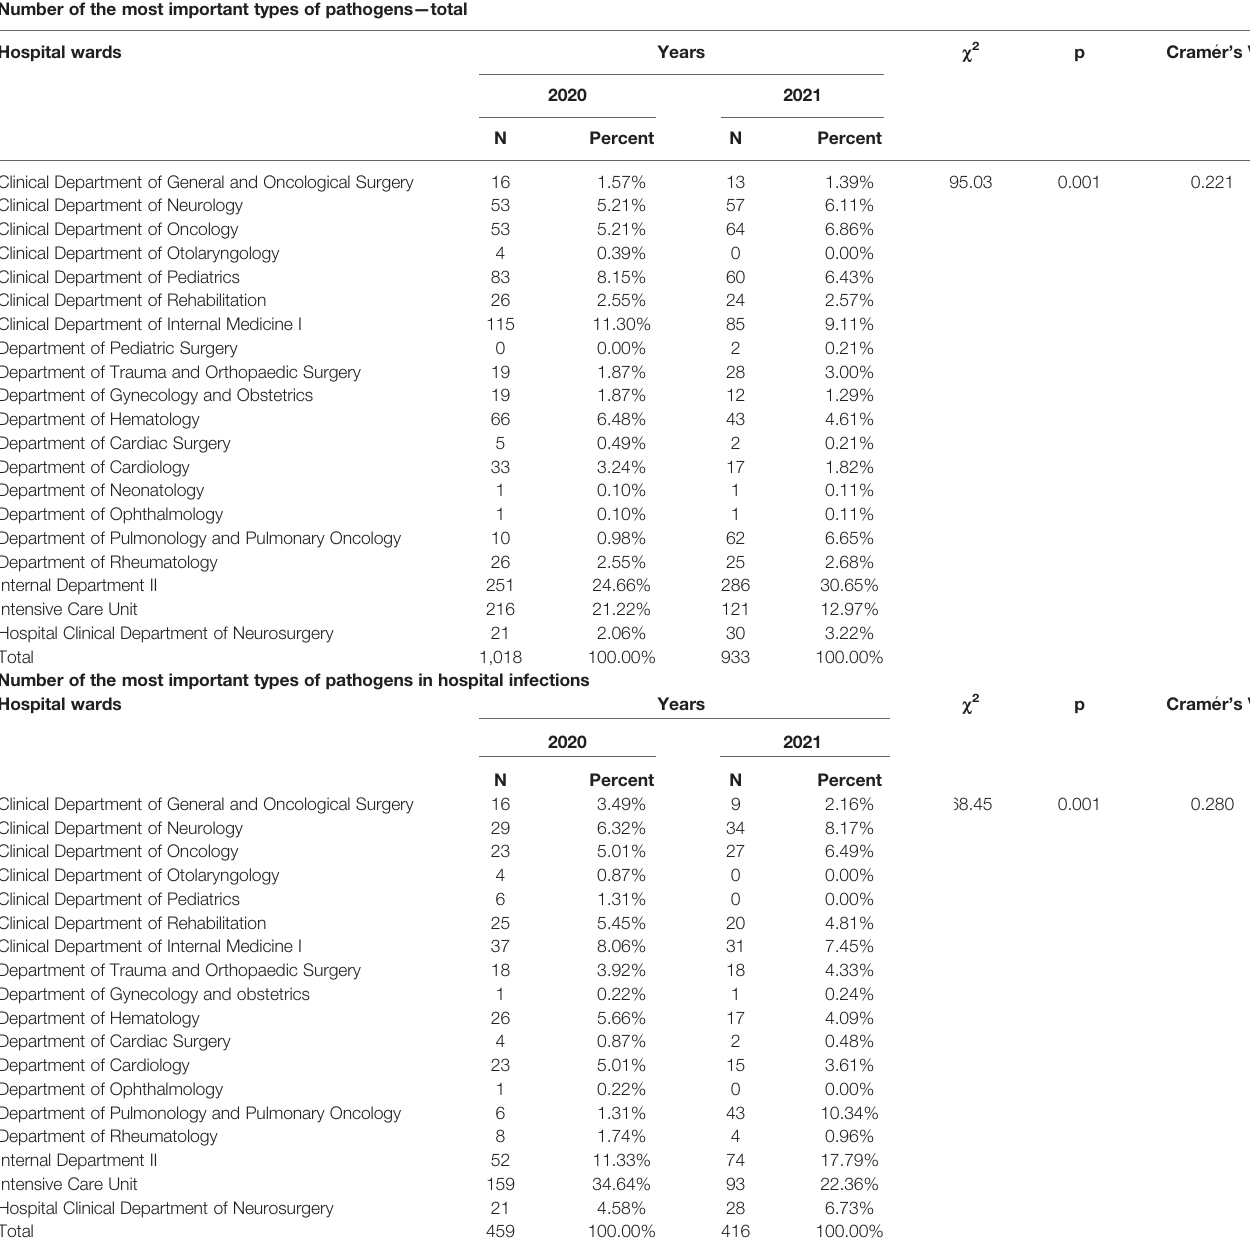
TABLE 5 | Presence of the most common types of pathogens on selected hospital